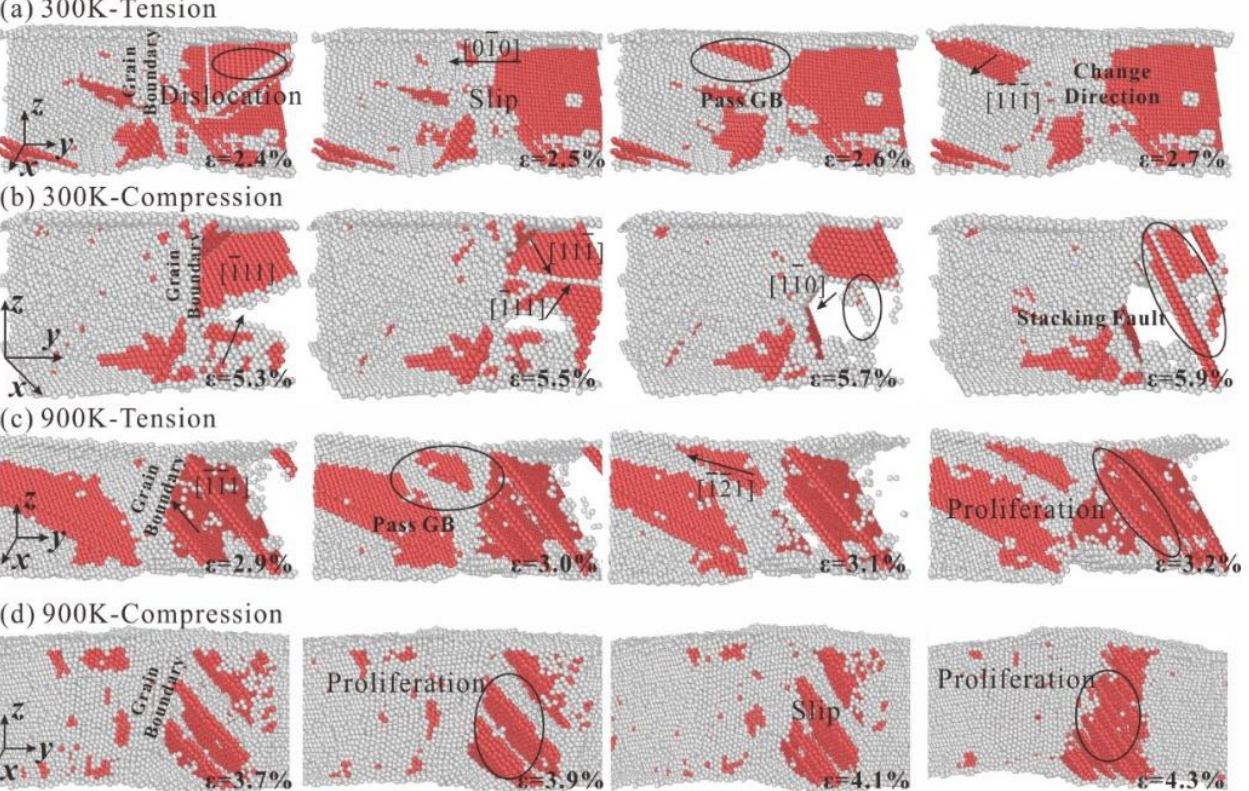
Figure 10. Microstructural evolution of polycrystalline HEA with grain number of 15, ( a ) Tensile load at 300 K, ( b ) Compressive load at 300 K, ( c ) Tensile load at 900 K, and ( d ) Compressive load at 900 K.